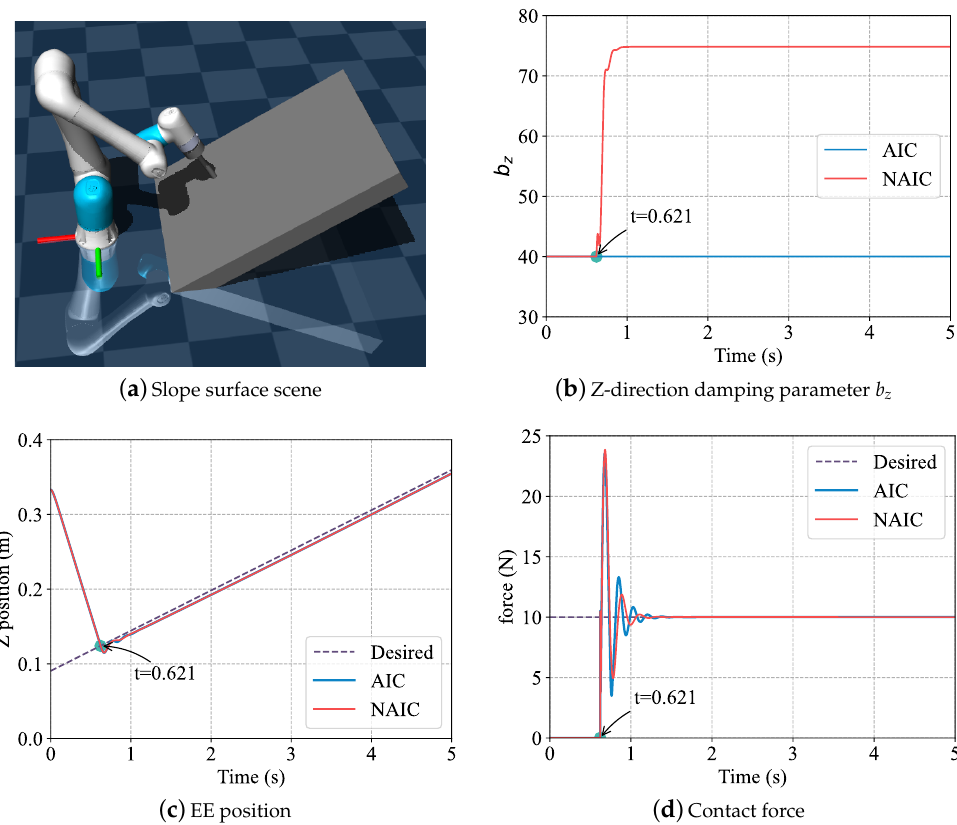
Figure 4. Force tracking with the slope surface. ( a ) Simulation scene. ( b ) Adaptive effect of damping parameters in the Z-direction. ( c ) The legend Desired means the environment position. ( d ) Force tracking result. When t = 0.621 s, the robot is in contact with the slope surface at Z = 0.124